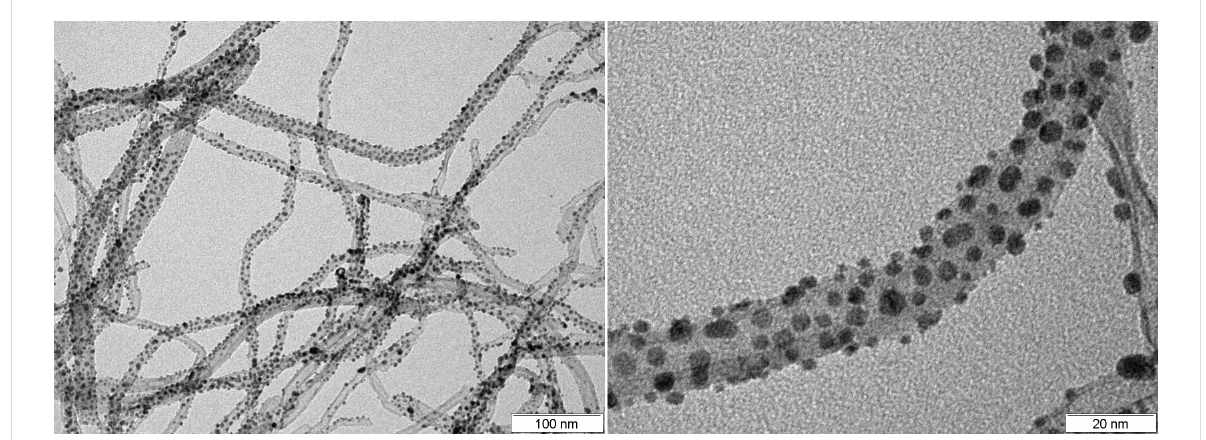
Figure 1: TEM images of MWCNTs decorated with gold nanoparticles.